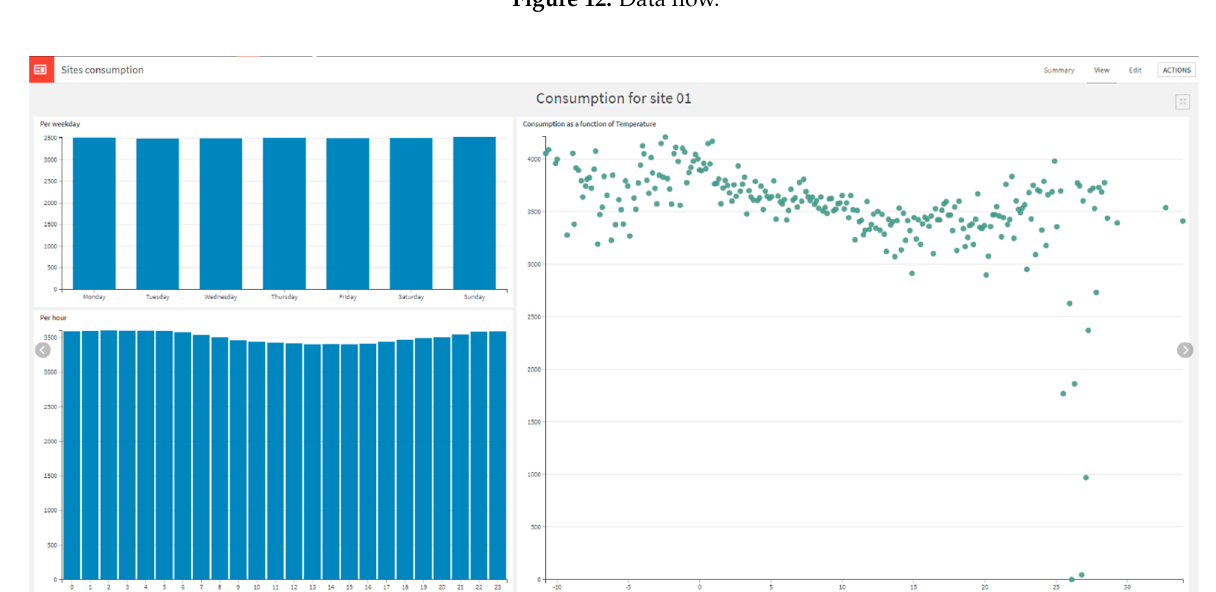
Figure 13. Energy consumption trend for a chemical plant.